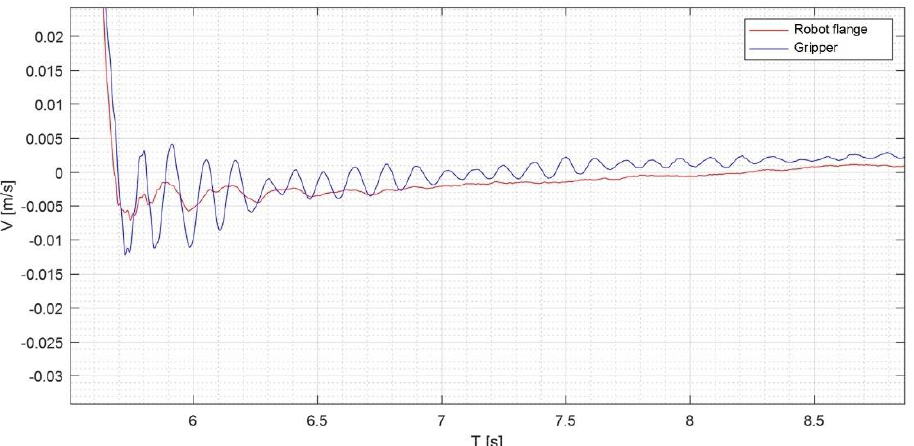
Figure 19. Area of the velocity diagram after stopping the robot for parameters V4000, ACC100.